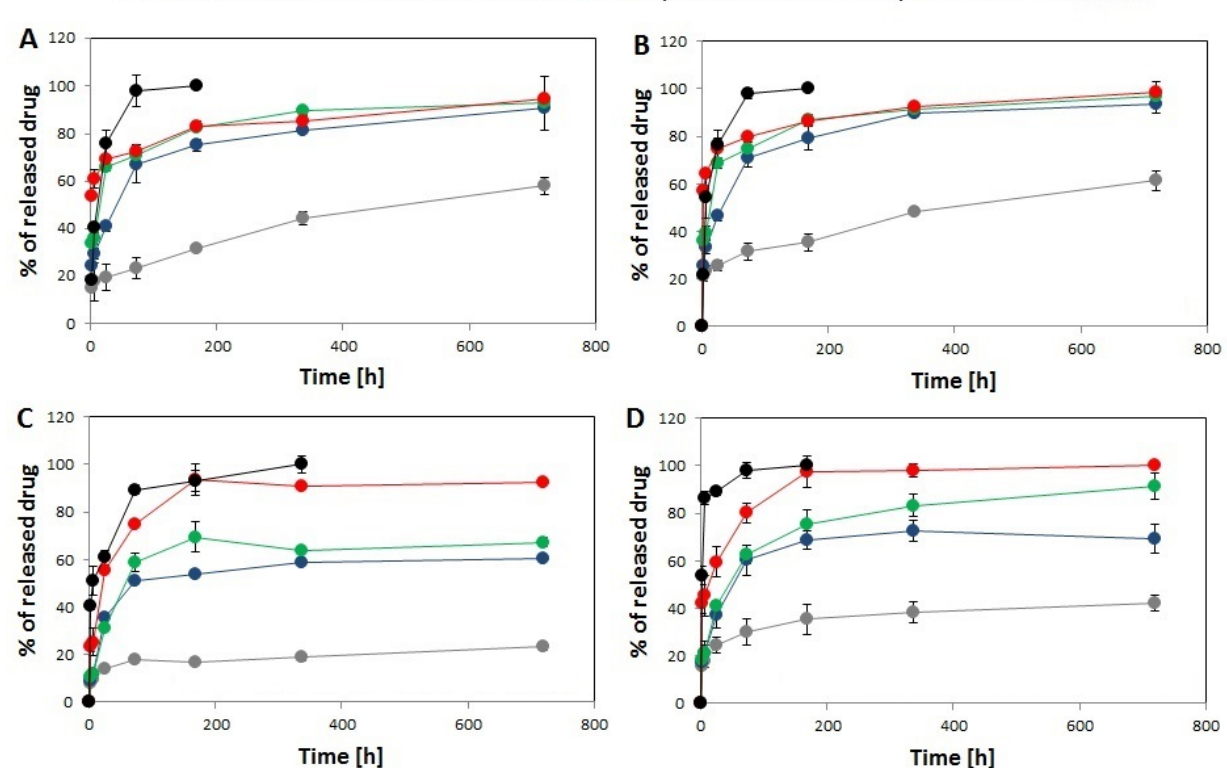
Figure 4. Cumulative release of rapamycine from Rap-loaded DDS ( A ), EpoB from EpoB-loaded DDS ( B ), rapamycine from Rap and EpoB-loaded DDS ( C ), and EpoB from Rap and EpoB-loaded DDS ( D ). (SD is shown as error bars, n = 3). Table 3. Comparison of the regression coefficients ( R 2 ) obtained after fitting the drug release data to the Korsmeyer–Peppas and Peppas–Sahlin